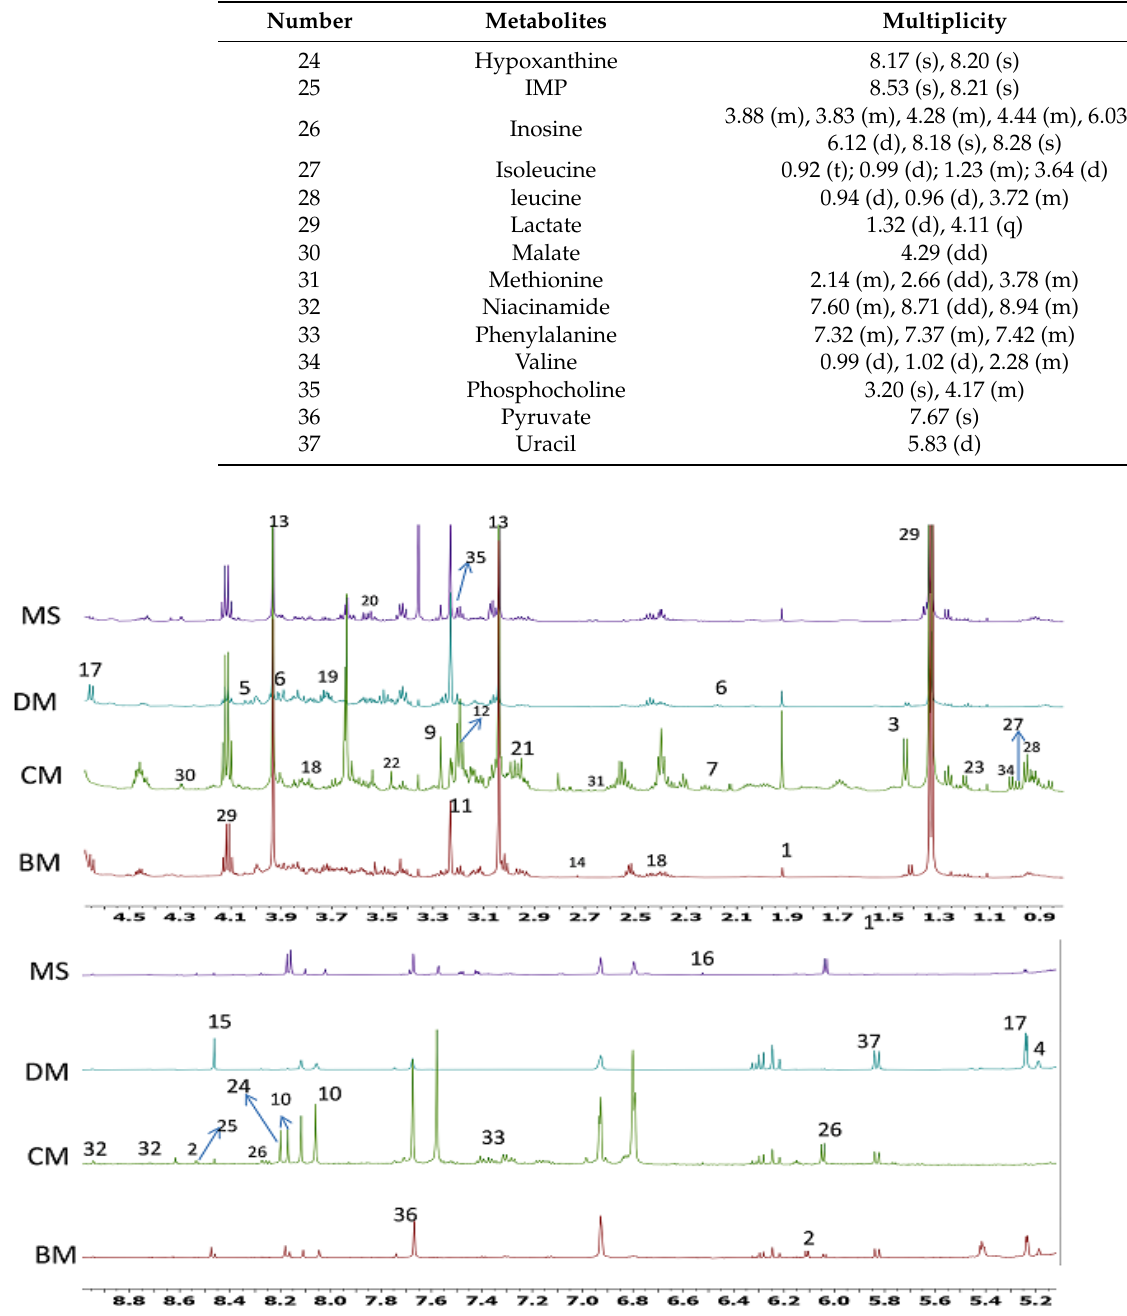
Figure 1. H-NMR spectra of MS (Chevon); DM (Donkey); BM (Beef); CM (Chicken). 1, Acetate; 2, ADP/AMP/ATP; 3, al-